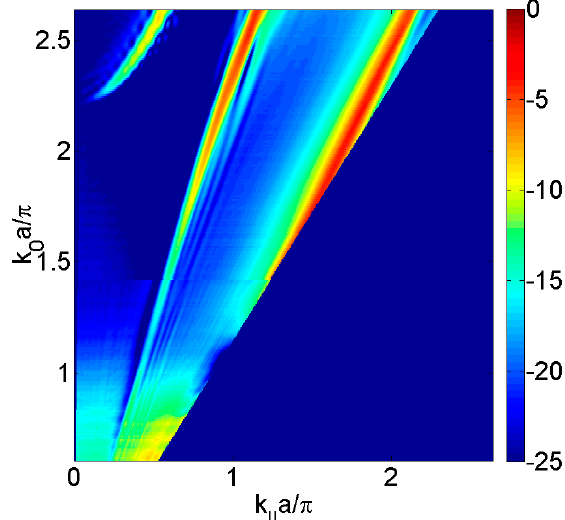
Figure 2. Measured transmitted sound power coefficient, τ , as a function of the parallel wavevector k ‖ · a / π in the Γ X direction and the normalized frequency k 0 · a / π , where a the array periodicity. The transmitted sound is represented in dB scale.